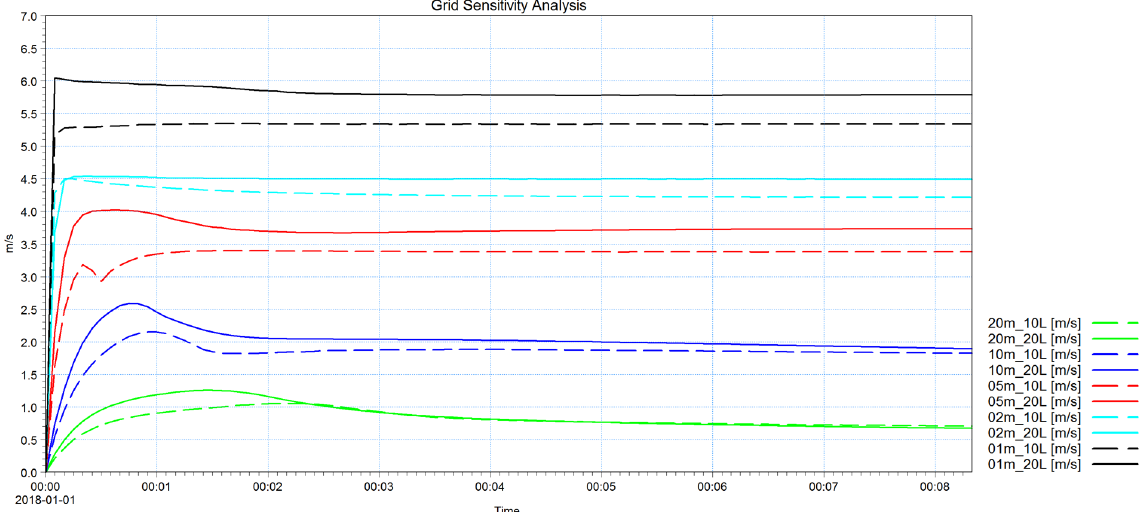
Figure 6. Model grid sensitivity analysis to the cell’s dimension. The different colors correspond to different horizontal resolutions. Dashed lines indicate the configurations with 10 layers, and solid lines indicate those with 20